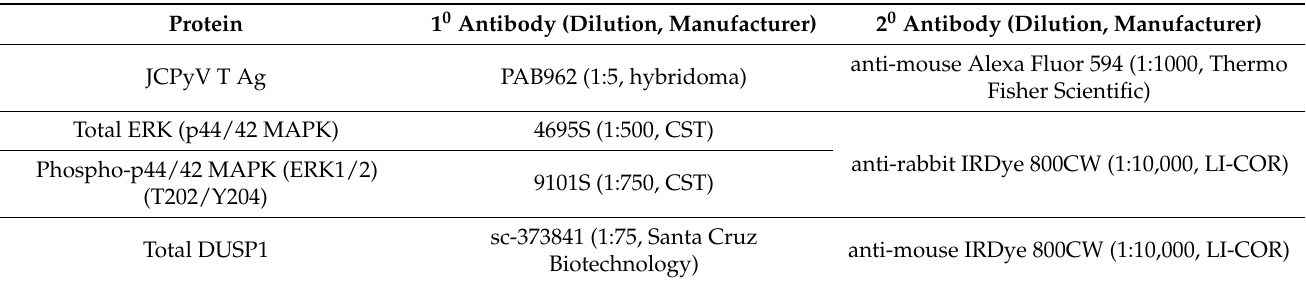
Table 1. Antibodies used in immunofluorescence and ICW